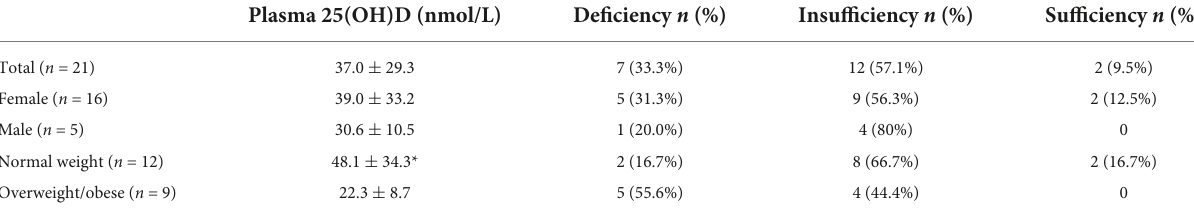
TABLE 4 Vitamin D status at